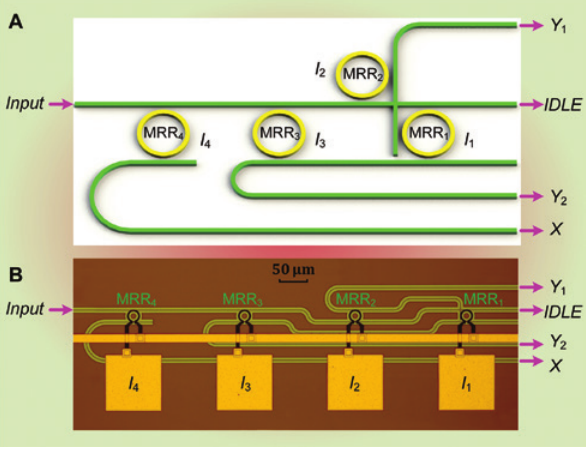
Figure 1: The device is designed and